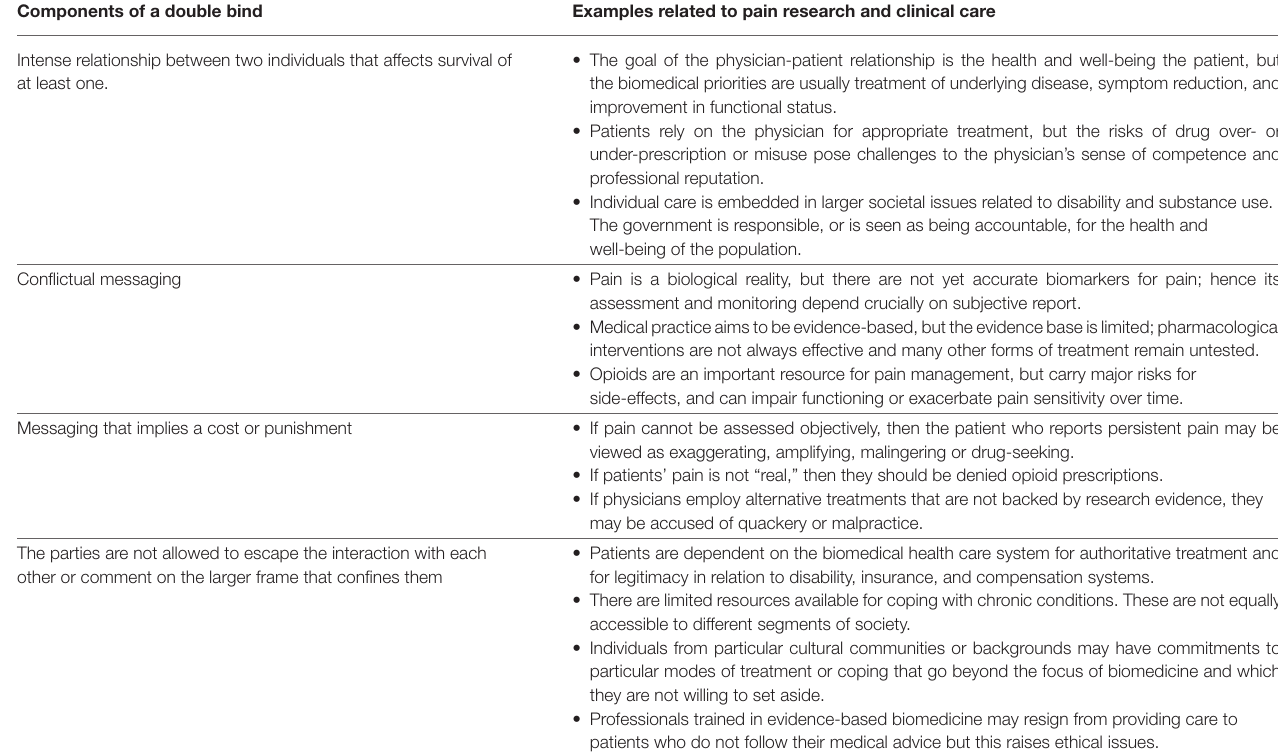
TABLE 1 | Examples of double binds in chronic pain communication. Components of a double bind Examples related to pain research and clinical care Intense relationship between two individuals that affects survival of at least